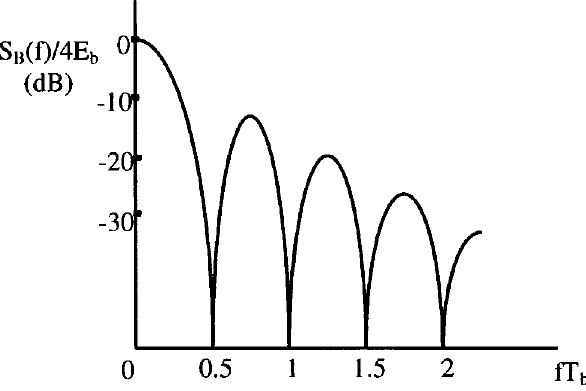
FIGURE 3 Normalized baseband power spectral of